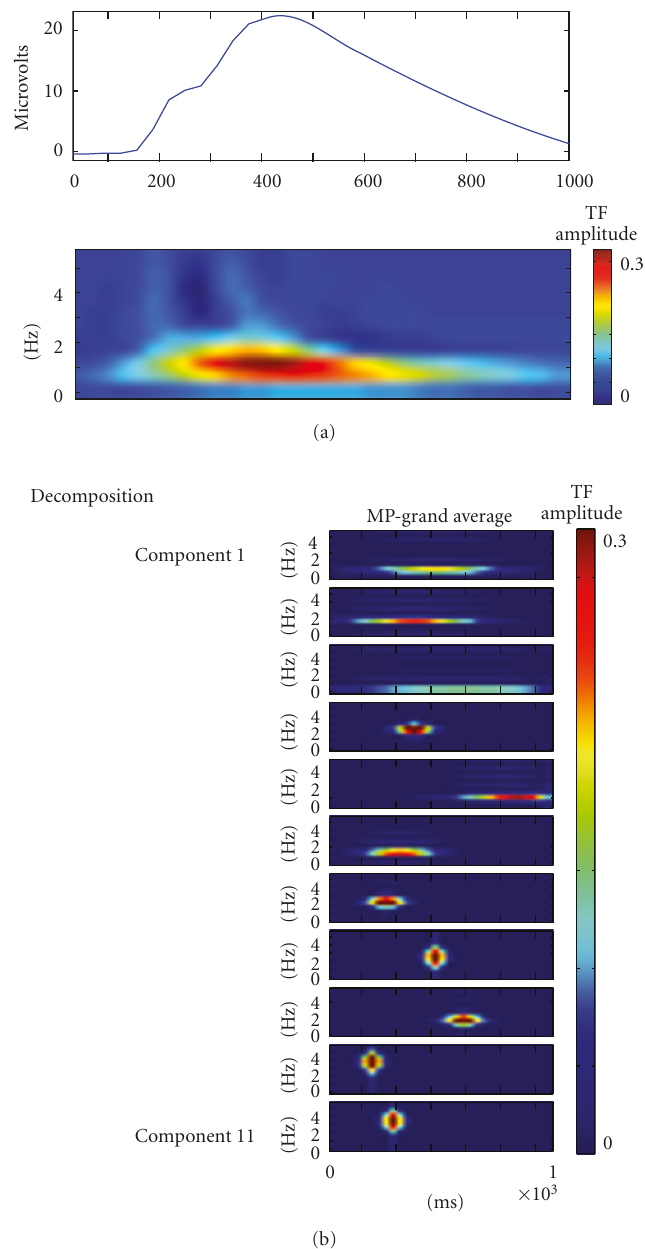
Figure 3: 11 Gabor logons extracted from the grand average of ERP